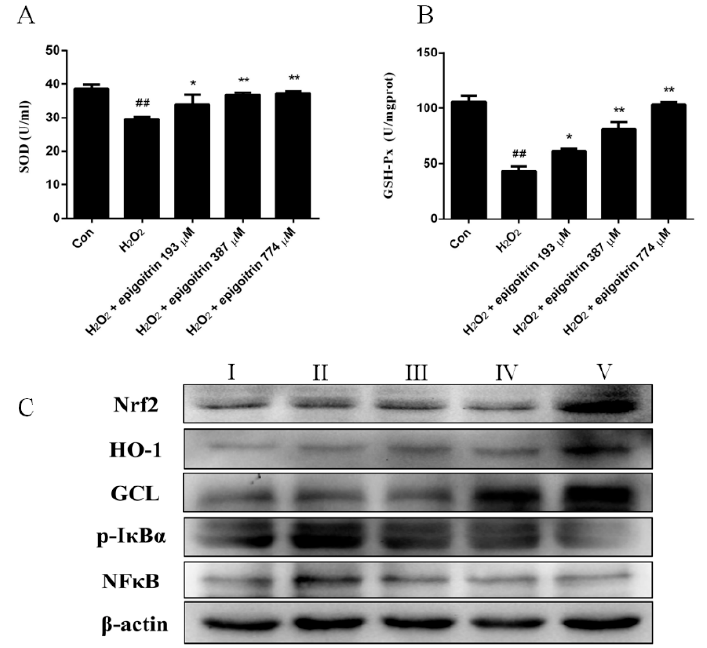
Figure 7. Anti-oxidative and anti-inflammatory effects of epigoitrin against H 2 O 2 -induced HepG2 cells. ( A , B ) Effect of epigoitrin on superoxide dismutase (SOD) and GSH-Px activities in H 2 O 2 -induced HepG2 cells. Values are the means ± SEM of three independent experiments. ## p < 0.01 versus control (untreated cells), ** p < 0.01, * p < 0.05 versus H 2 O 2 -treated cells; ( C ) Effect of epigoitrin on the expression of Nrf2, GCL, HO-1, p-I κ B α , and NF κ B in H 2 O 2 -induced HepG2 cells. Cells were treated with H 2 O 2 (0.4 mM, for 2 h) after pretreatment with epigoitrin for 12 h. Protein expression was then detected by western blot analysis. Groups are as follows. I: saline; II: saline + H 2 O 2 ; III: epigoitrin 193 µ M + H 2 O 2 ; IV: epigoitrin 387 µ M + H 2 O 2 ; V: epigoitrin 774 µ M + H 2 O 2 .